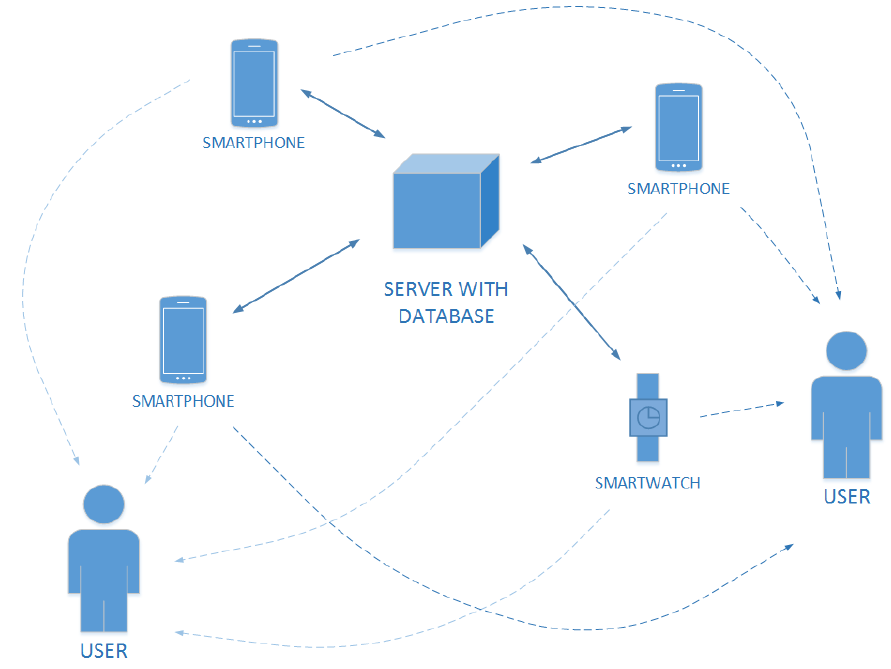
Figure 2. Visualization of communication between components in the proposed